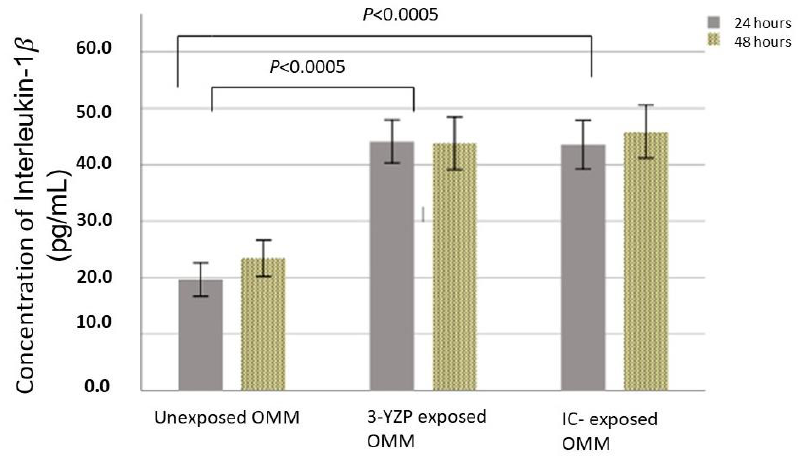
Figure 2. IL-1 β released after exposure of the 3-D oral mucosal model to 3-YZP and IC, after 24 and Figure 2. IL- 1β released after exposure of the 3 -D oral mucosal model to 3-YZP and IC, after 24 and 48 h. Error bars represent standard deviation. 48 h. Error bars represent standard deviation.